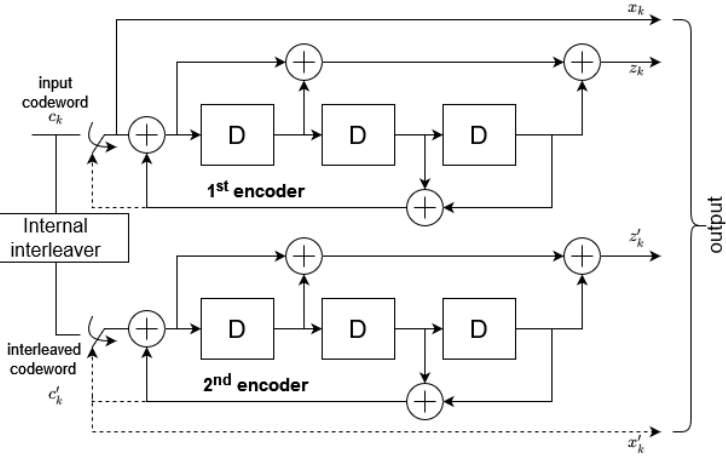
Figure 3. Turbo encoder with a rate of 1/3.